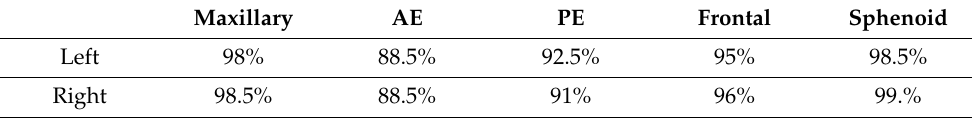
Table 1. Analysis agreement for our automatic segmentation result among three observers.